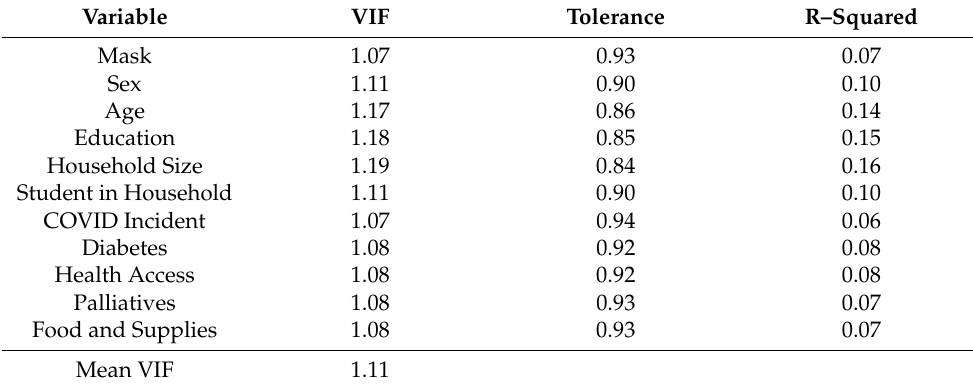
Table 3. Model diagnostic test.